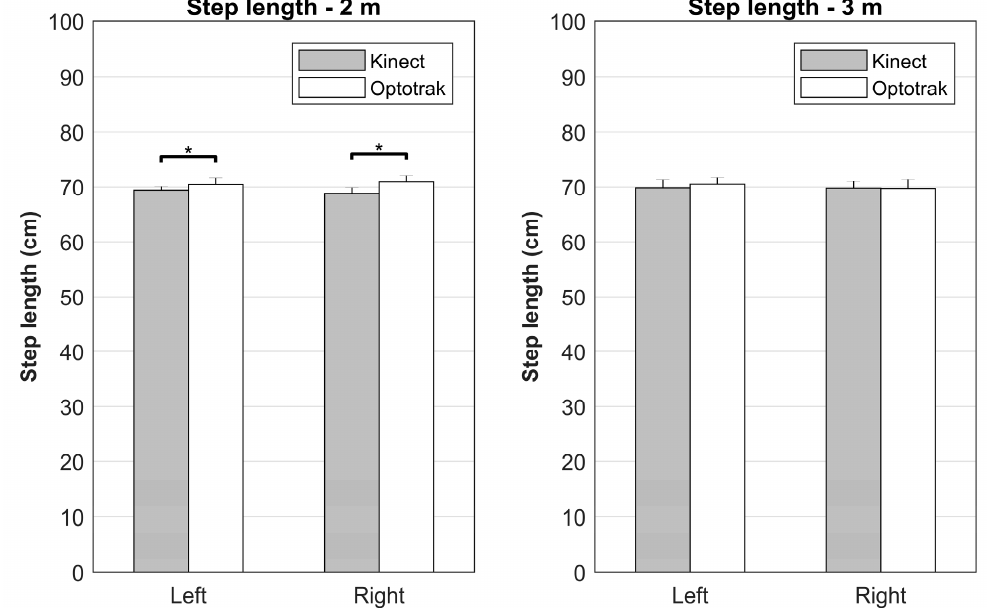
Figure 4. Visual representation of the interaction effect of System, Distance and Imposed step length. Significant between-systems differences in step length were only found at 2 m, with larger biases for larger imposed step lengths.